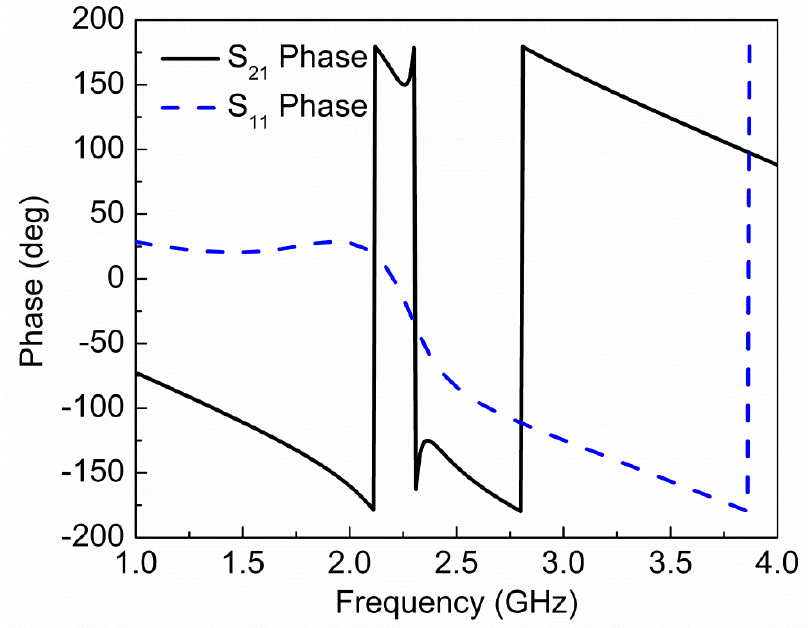
Figure 3. Phase of simulated reflection ( S 11 ) and transmission ( S 21 ) coefficient for the proposed sensor. A sudden change in phase occurs at resonance frequency.